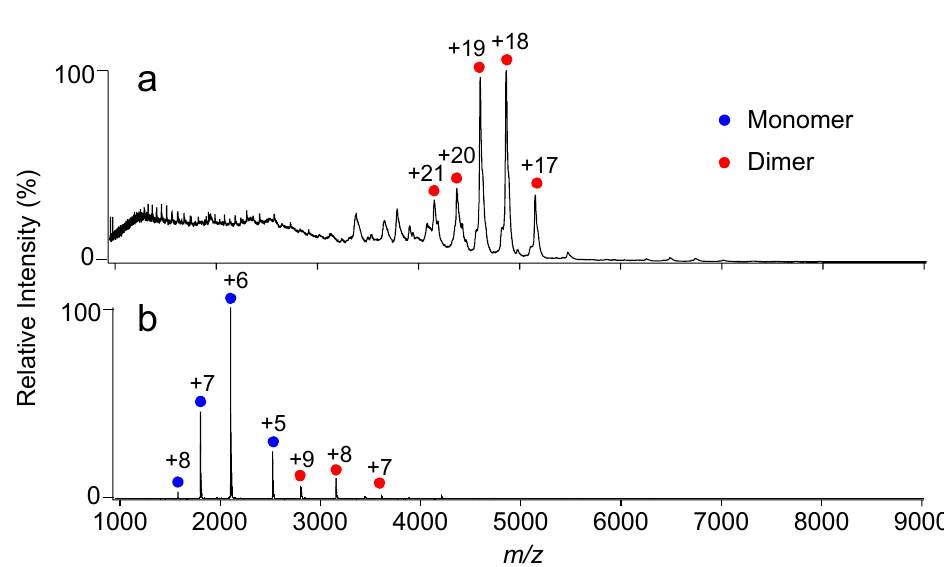
Figure 3. Native MS analysis of SasA and its mutant. Mass spectra of ( a ) TeSasA and ( b ) TeSasA N . The blue and red circles show the ion series of the SasA monomer and dimer, respectively.